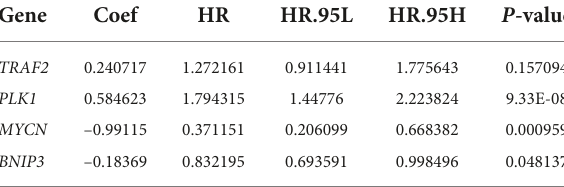
FIGURE4 Univariate Cox regression analysis of differentially expressed NRGs.